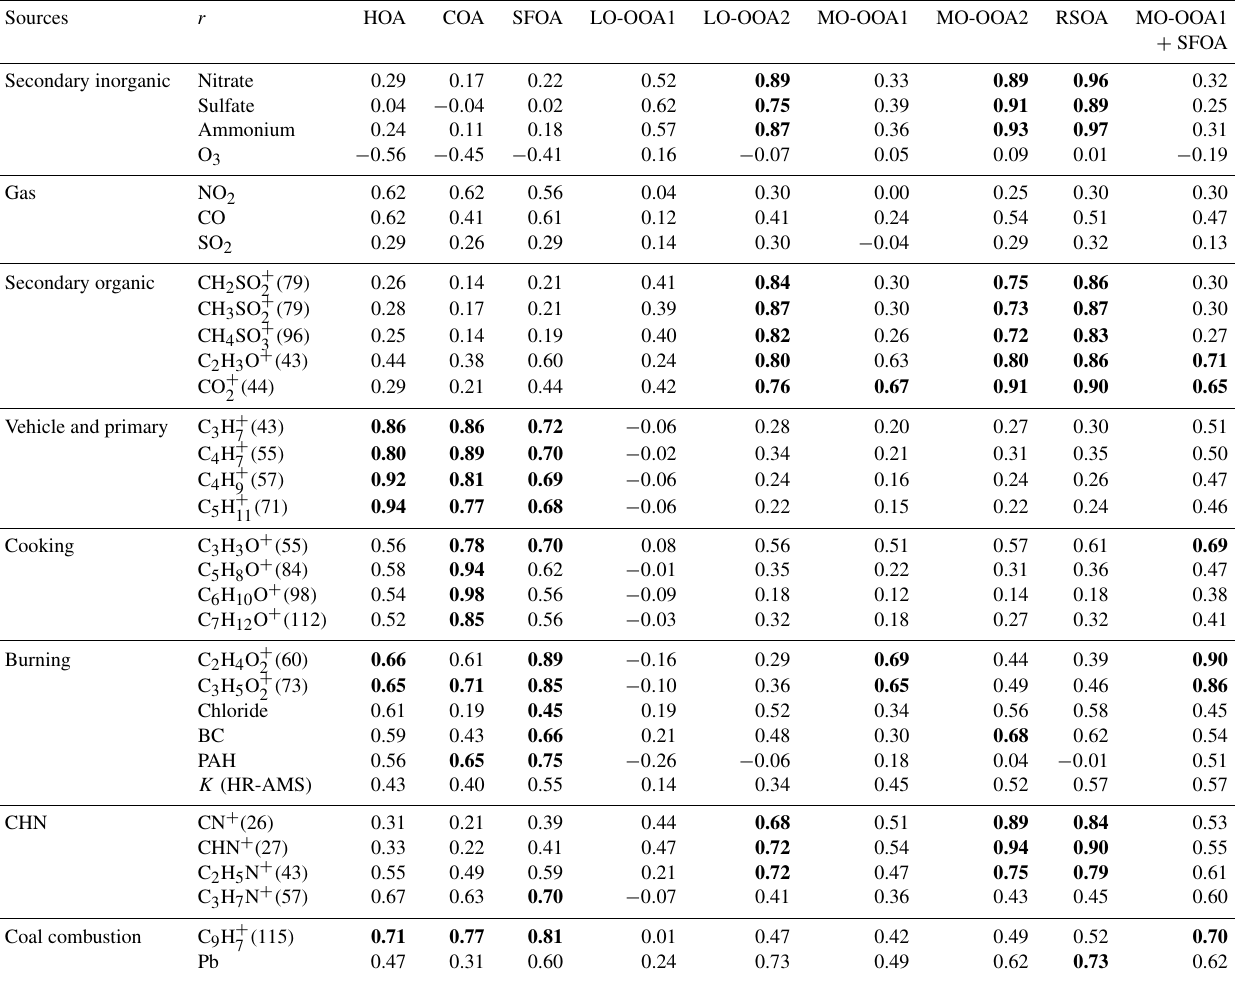
Table 1. Correlation coefficient (Pearson’s r ) for the linear regression between the factors of the organic aerosols (OA) and the various particle- and gas-phase species and